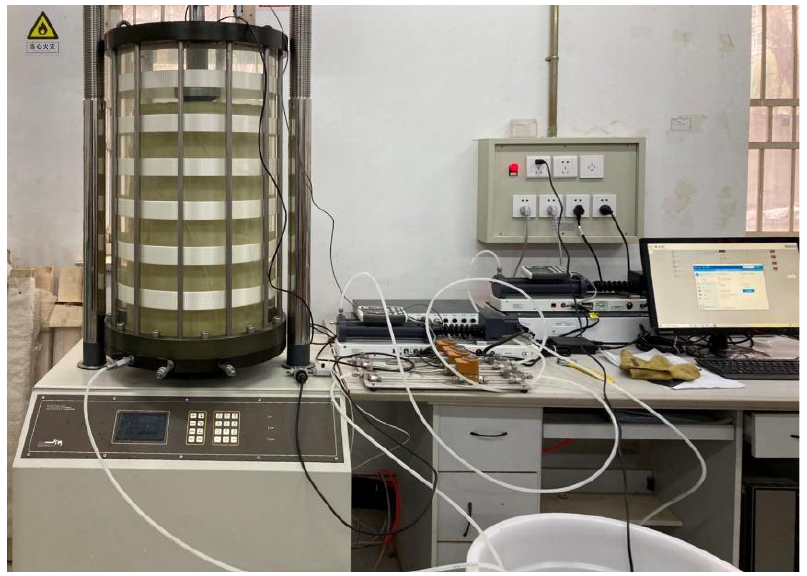
Figure 3. Large-scale triaxial compression testing machine.